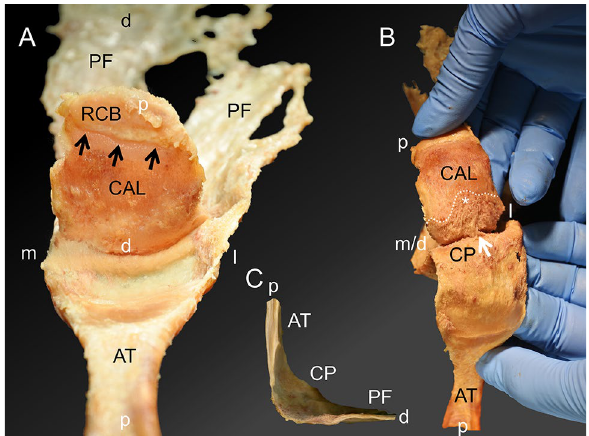
Figure 4. Macroscopic observations during the separation of the Achilles tendon-calcaneus-plantar fascia complex (AT-calcaneus-PF complex). ( A ) The AT-calcaneus-PF complex can be observed looking from proximal to distal after the AT was separated from its weak attachment on the calcaneus and reverted backwards. ( B ) The calcaneal tuberosity becomes visible if the separation of the AT from the calcaneus is continued. The white arrow points at the median fibrous septum originating from the calcaneus and contributing to the calcaneal periosteum, which is depicted more proximally in the plastinate and histology sections shown in Fig. 7. ( C ) The macroscopic transition of ligamentous structures between the AT and the PF is shown after the calcaneus was removed (view from medial to lateral onto a sagittal plane after the AT-calcaneus-PF complex had been longitudinally divided into two parts). AT, Achilles tendon; black arrows, transverse insertion line; CAL, calcaneus; CP, calcaneal periosteum; PF, plantar fascia; RCB: retrocalcaneal bursa, white asterisk, most proximal point of the calcaneal tuberosity; d, distal; m, medial; l, lateral; p,